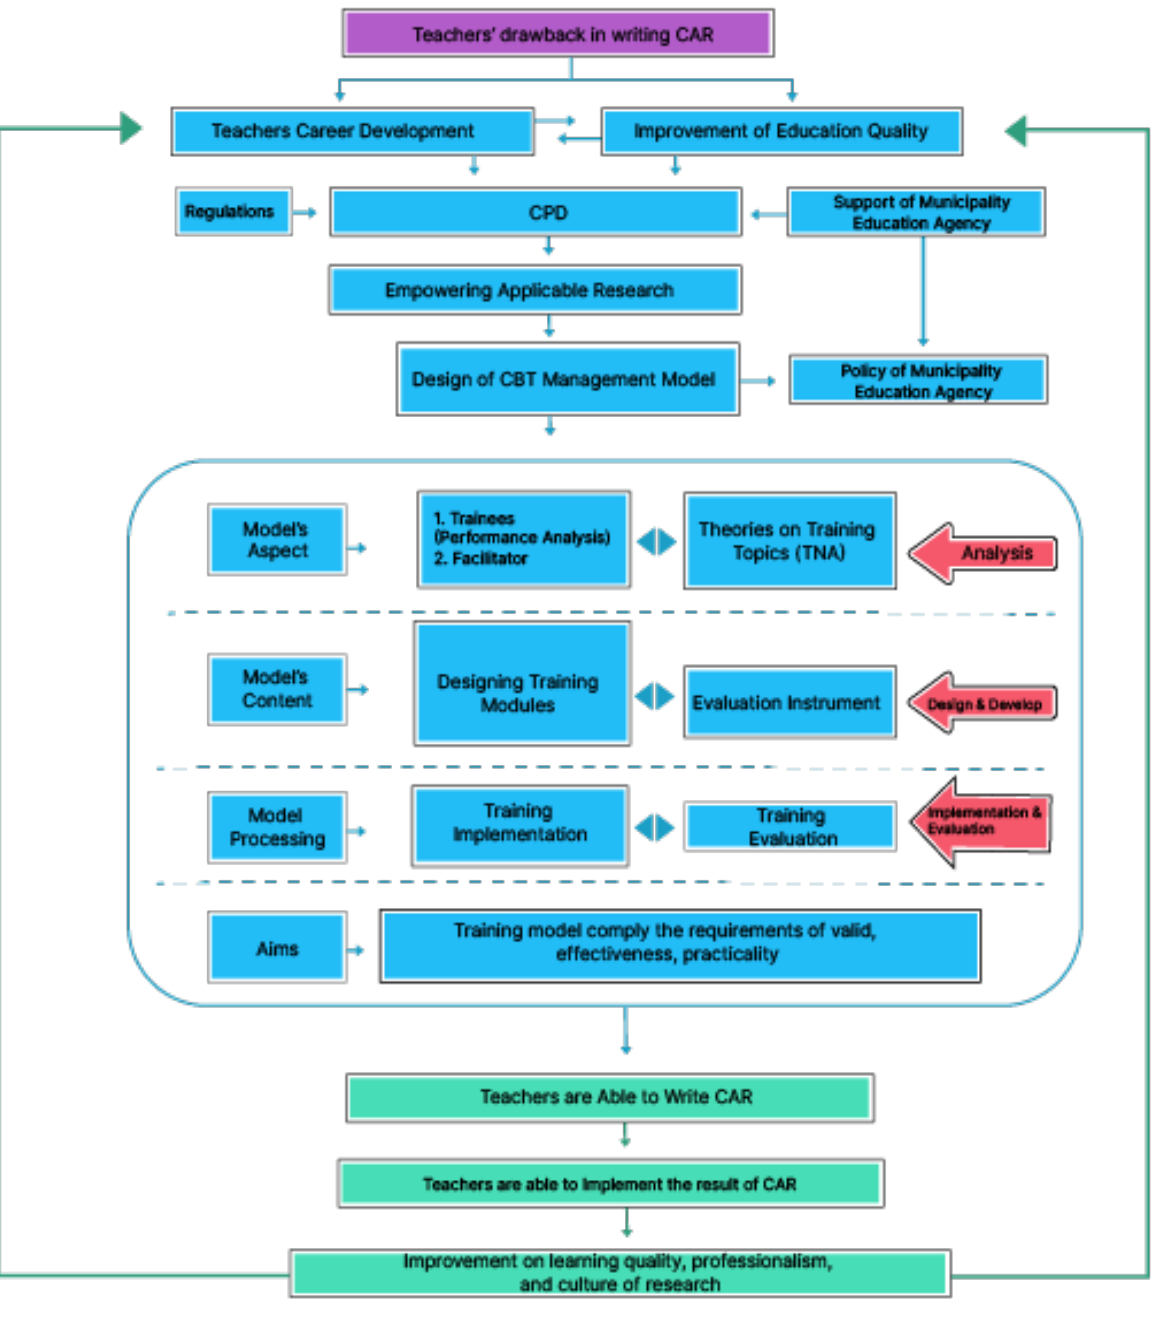
Figure 3. Final model of